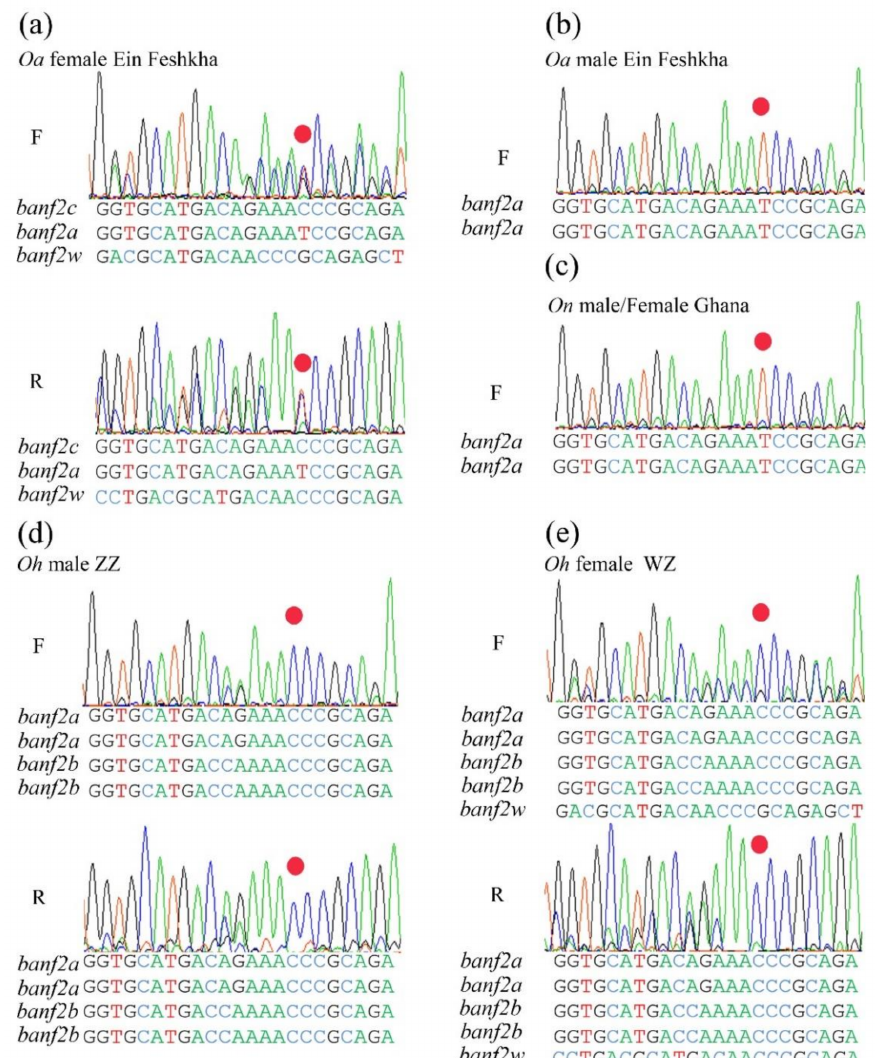
Figure 5. Polymorphism in Sanger chromatograms of third exon of banf2 genes of three purebred Oreochromis species. Typical traces are presented for female ( a ) and male ( b ) of Oreochromis aureus ( Oa ); common trace for female and male of O. niloticus ( On ) ( c ) and male ( d ) and female ( e ) of O. urolepis hornorum ( Oh ). Copy proportion analysis was based on both forward (F) and reverse (R) sequencing orientations. The nucleotide sequences below the chromatogram traces were interpreted using Tide software, which, by trace decomposition analysis, estimated that the banf2w was 33% of the signal intensity in Oa and was 20% in Oh . The red dots mark an informative position disclosing multiple copies in Oa females carrying either C, T or